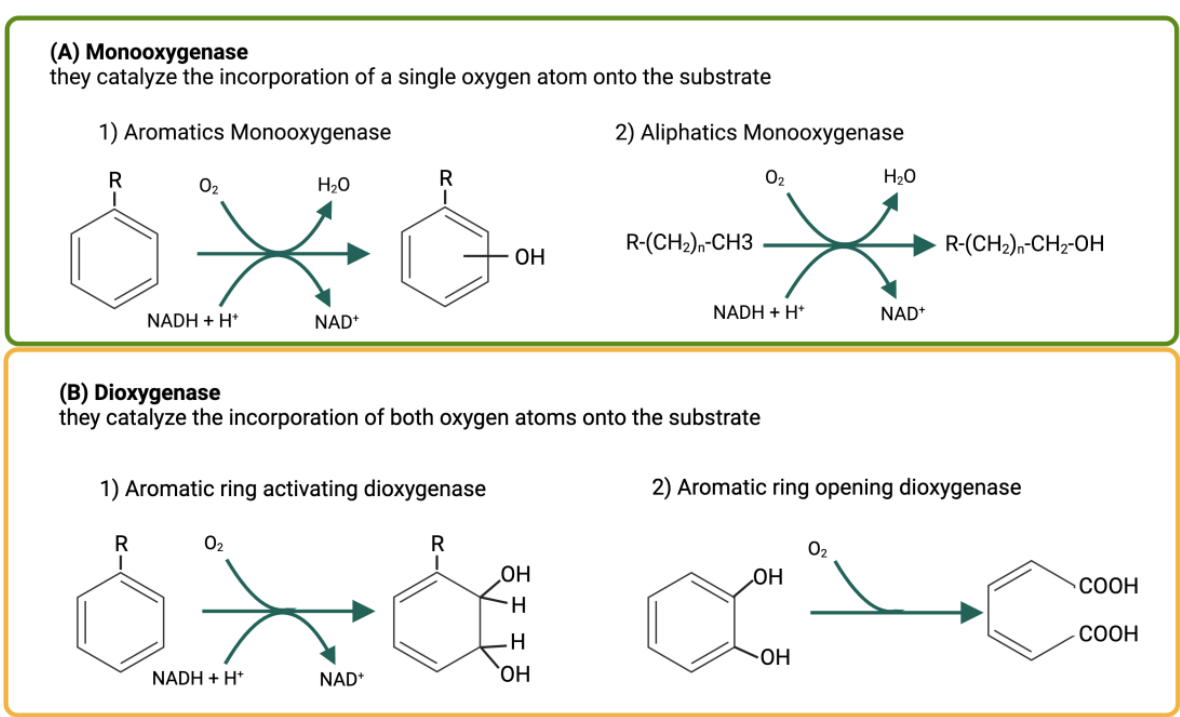
Figure 2. ( A ) Monooxygenases introduce one molecular oxygen atom into aromatic rings (on the left) or alkyl chains (on the right). ( B ) Dioxygenases introduce two oxygen atoms into aromatic substrates, activating an aromatic ring by forming dihydroxy compounds (on the left) or causing ring rupture of previously activated compounds (on the right).